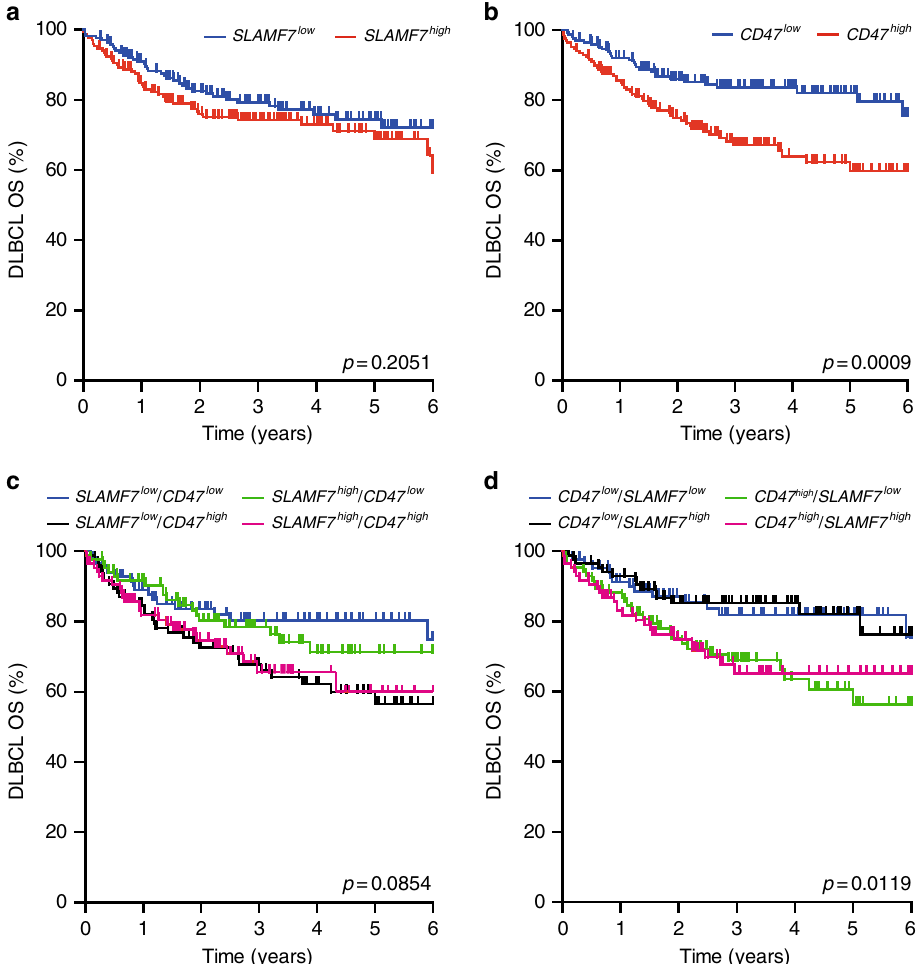
Fig. 4 mRNA expression of SLAMF7 does not, but of CD47 does, associate with survival in DLBCL patients. a Kaplan – Meijer curve analysis of survival of DLBCL patients within high and low SLAMF7-expressing quartiles. b Kaplan – Meijer curve analysis of survival of DLBCL patients within high and low CD47- expressing quartiles. c Kaplan – Meijer curve analysis of survival of DLBCL patients within high and low SLAMF7-expressing quartiles additionally sorted on high and low expression of CD47. d Kaplan – Meijer curve analysis of survival of DLBCL patients within high and low CD47-expressing quartiles additionally sorted on high and low expression of